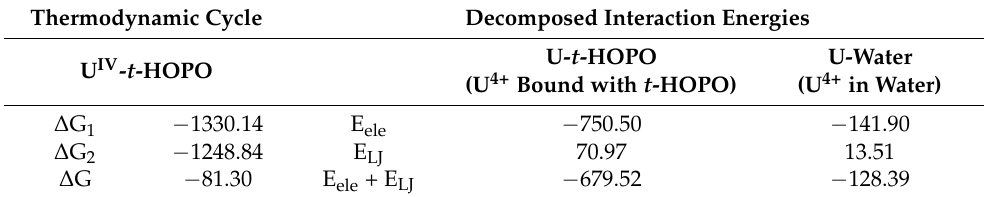
Table 2. The calculated ∆ G 1 , ∆ G 3 and ∆ G bind (kcal/mol) in the evaluation of the binding strength of U 4+ with t -HOPO via the FEP method, and the decomposition of the U IV - t -HOPO and U IV -water interaction energies (kcal/mol) averaged over the 100 ns-long MD trajectories. Thermodynamic